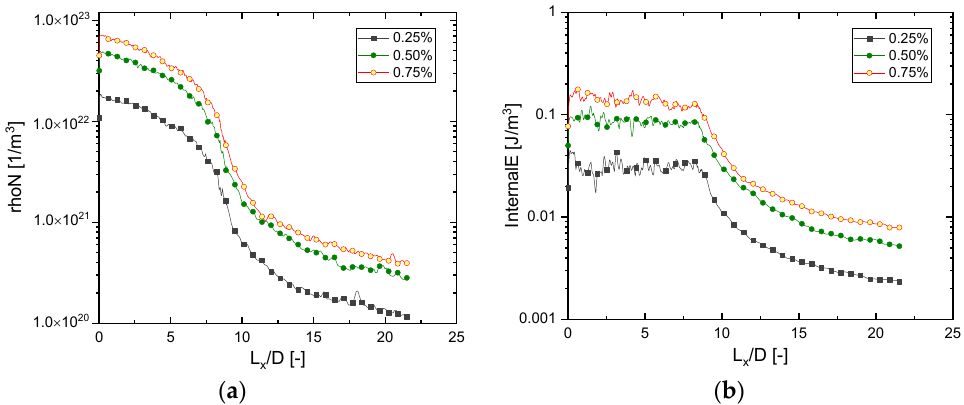
Figure 13. Molecular number density and internal energy profiles along the nozzle axis with different valve openings at t = 0.1 ms. ( a ) Molecular number density ( b ) Molecular internal energy.